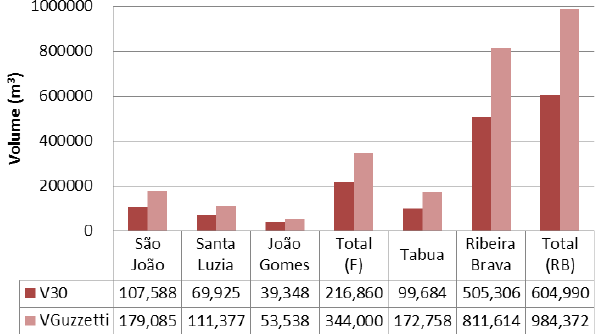
Fig. 9. Estimated volume for each affected basin and for each con- sidered equation. F – Funchal municipality and RB – Ribeira Brava municipality.